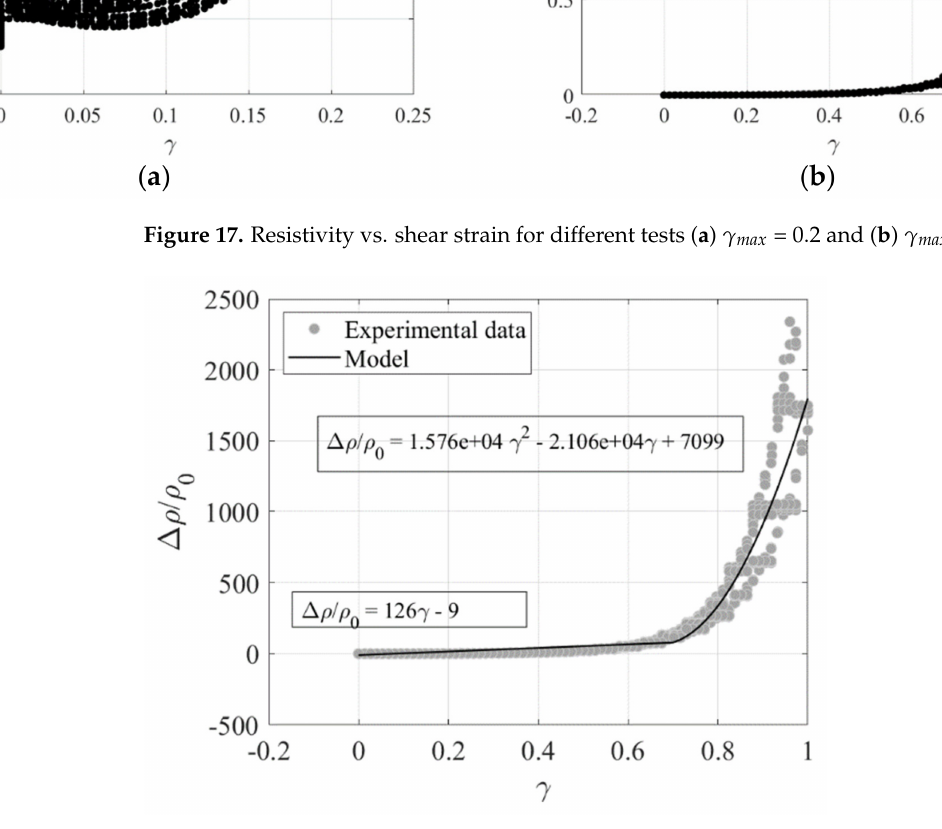
Figure 18. Variation of resistivity vs. shear